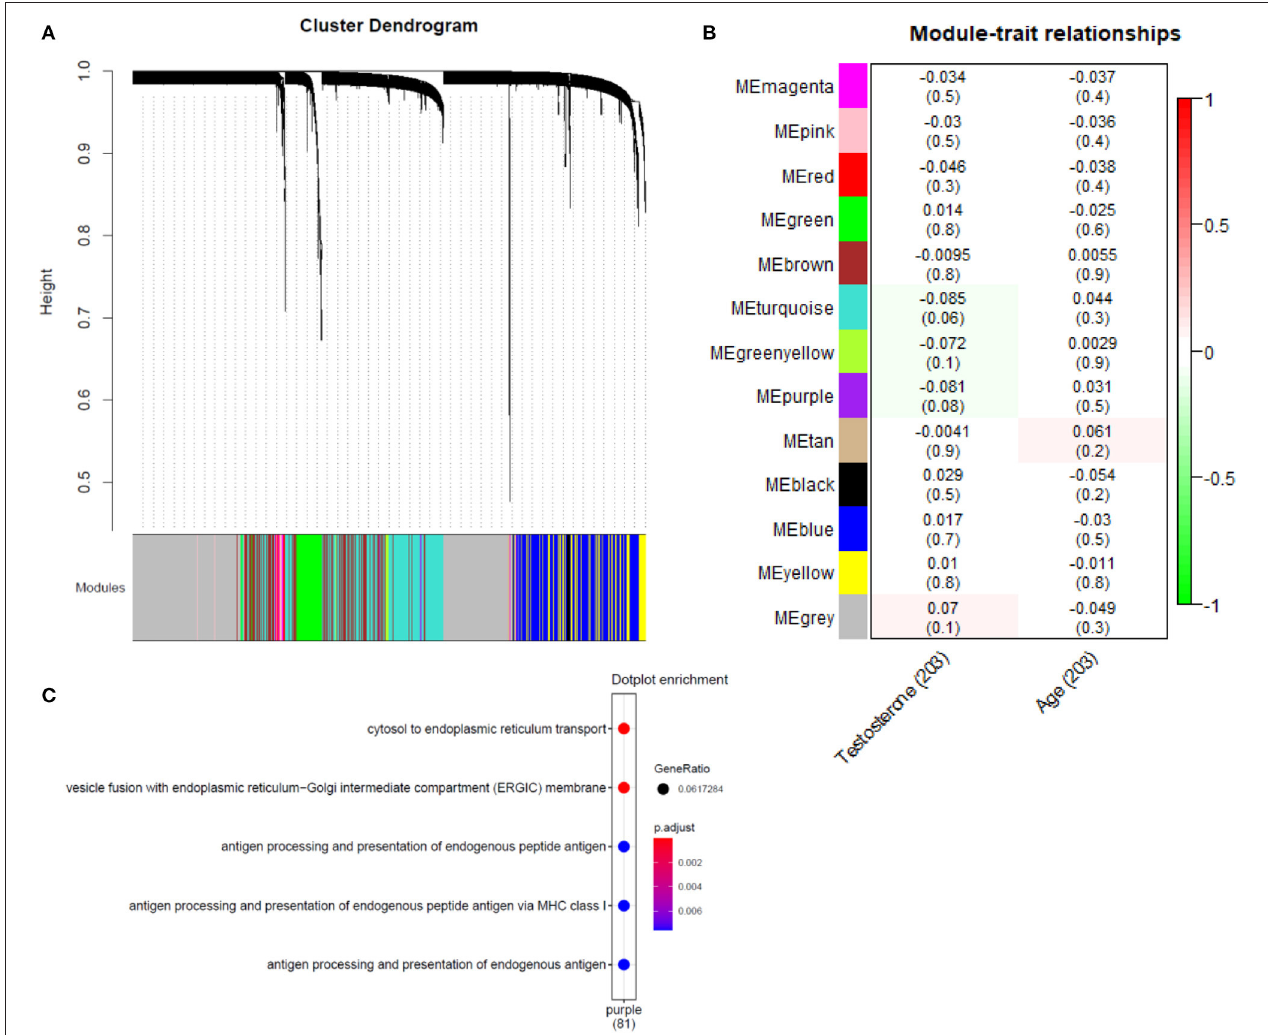
FIGURE 4 | Association analysis of gene co-expression networks with testosterone levels. (A) Hierarchical cluster tree of 12,756 genes, height (y-axis) is determined using the average gene linkage from the topological overlap measure, which incorporates information about both co-expression and connectivity in the network. A total of 14 modules were assigned based on the dynamic hybrid branch cutting method and are shown along the x-axis in different colors. Genes in the same module have higher co-expression and present higher connection in the network. (B) Correlation of module eigengenes (a composite measure of the combined expression of the genes from each module) with testosterone levels and age of the participants, p -values for the correlation are in parenthesis. (C) Gene enrichment GO terms obtained for the purple module, nominally associated with testosterone levels (no significant enrichment was found for turquoise